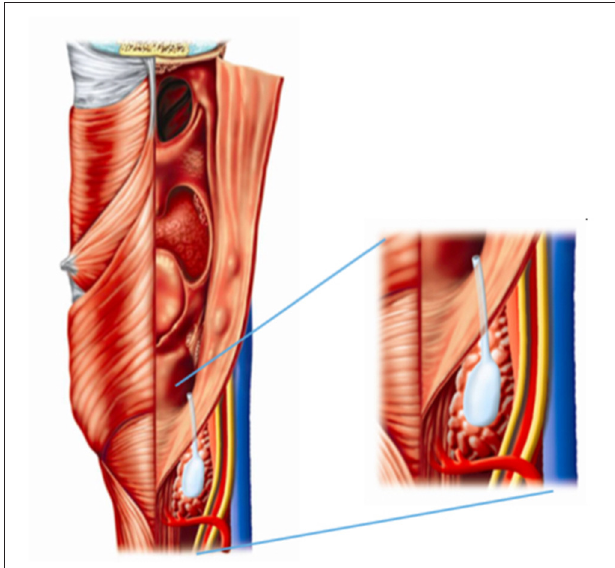
FIGURE 1 | The predicted tract of a fourth branchial anomaly based on embryological